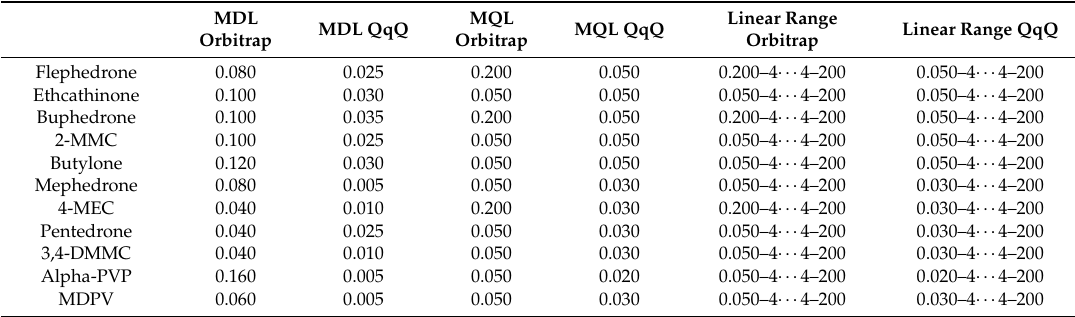
Table 3. Linearity, method detection limits (MDLs) and method quantification limits (MQLs) for Orbitrap and QqQ in ng mL − 1 for the determination of synthetic cathinones in